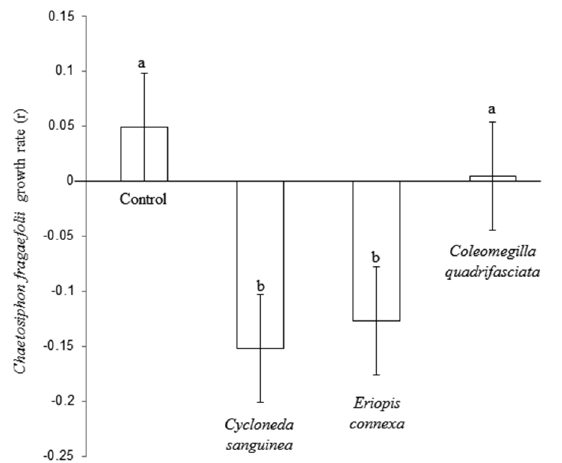
Figure 3 - Results of experimental greenhouse assay showing the reduction in the population growth of C. fragaefolii in the presence of C. sanguinea , E. connexa and C. quadrifasciata in strawberry plants. Different letters indicate significant differences ( P